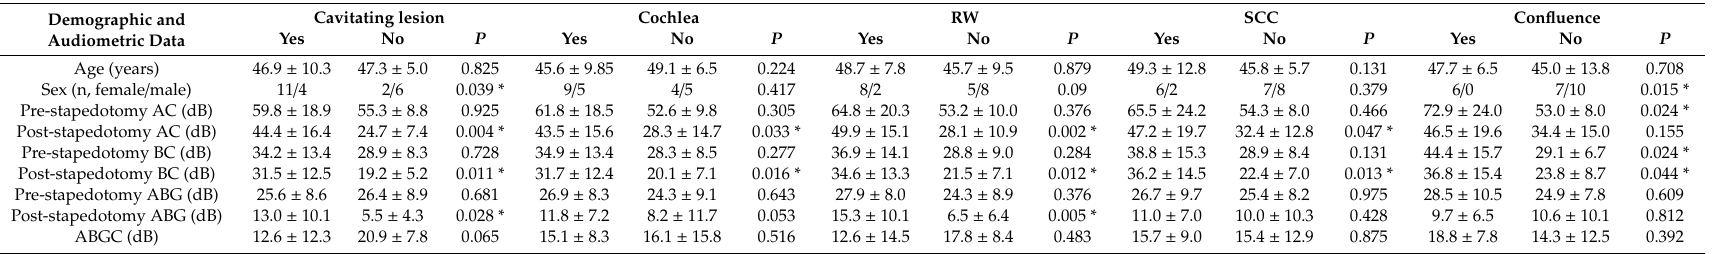
Table 2. Demographic and Audiometric Results according to the Retrofenestral